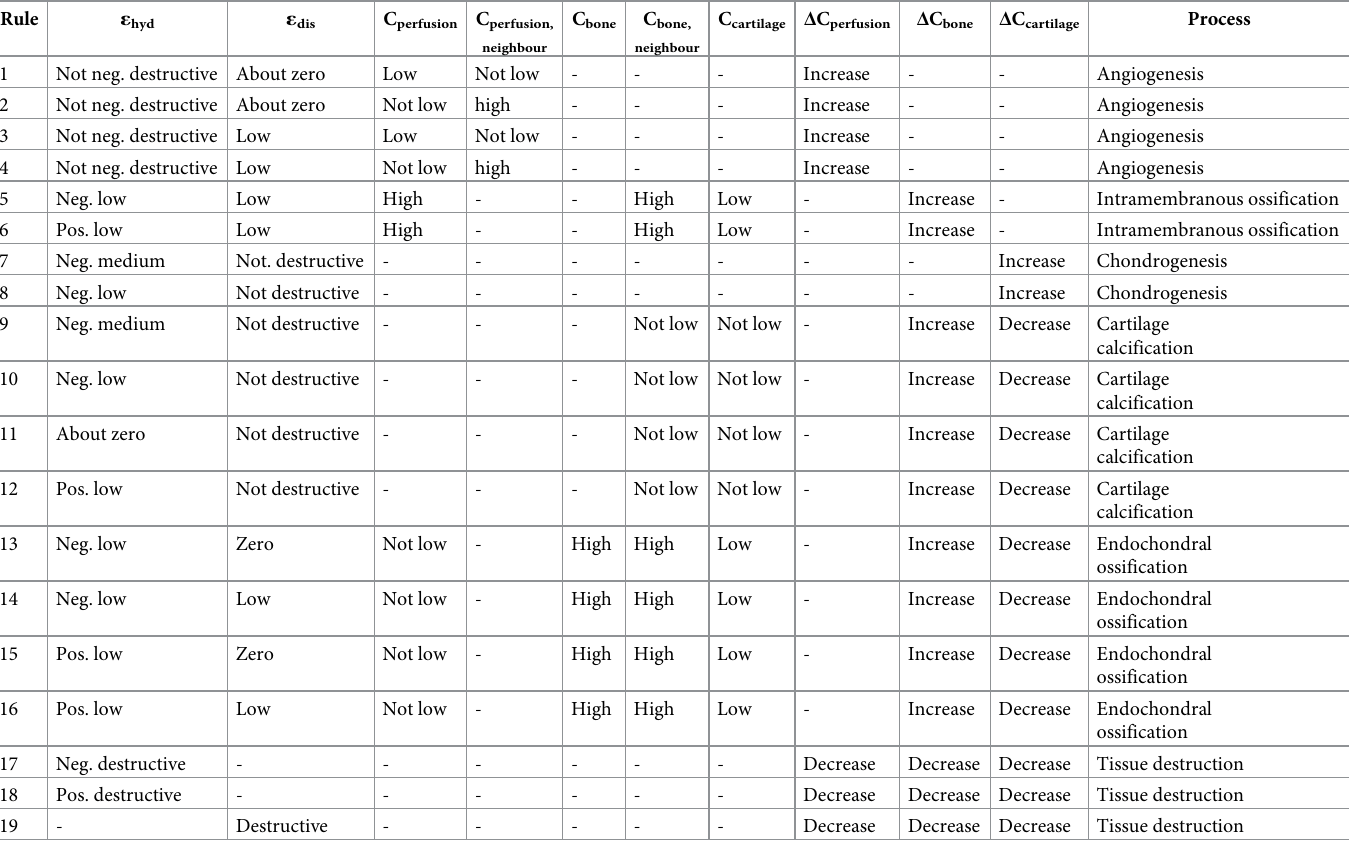
Table 2. Tissue differentiation rules describing biological processes within the callus region implemented in the fuzzy controller [29,30]. Rule ε hyd Not neg. destructive About